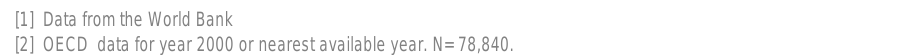
Figure A10. Correlations involving control variables. 30 Nations, 84,344 individual respondents.